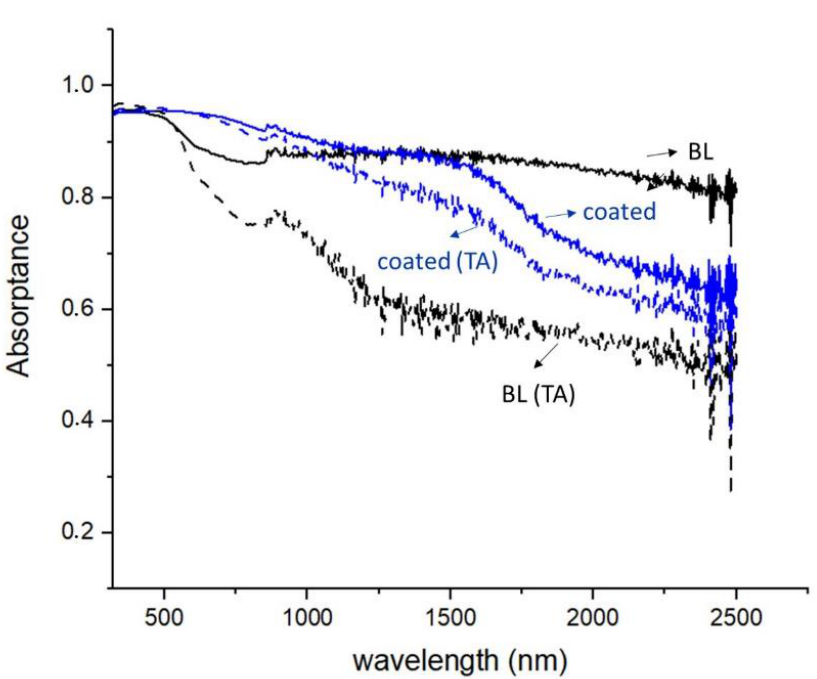
Figure 9. Solar absorptance of uncoated (BL) and black pigment coated bauxite proppants before and after thermal aging (TA).